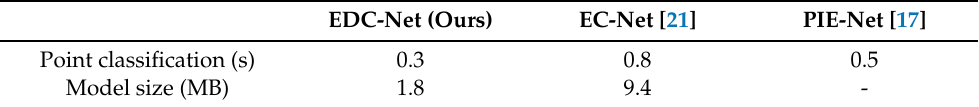
Table 3. Complexity analysis of